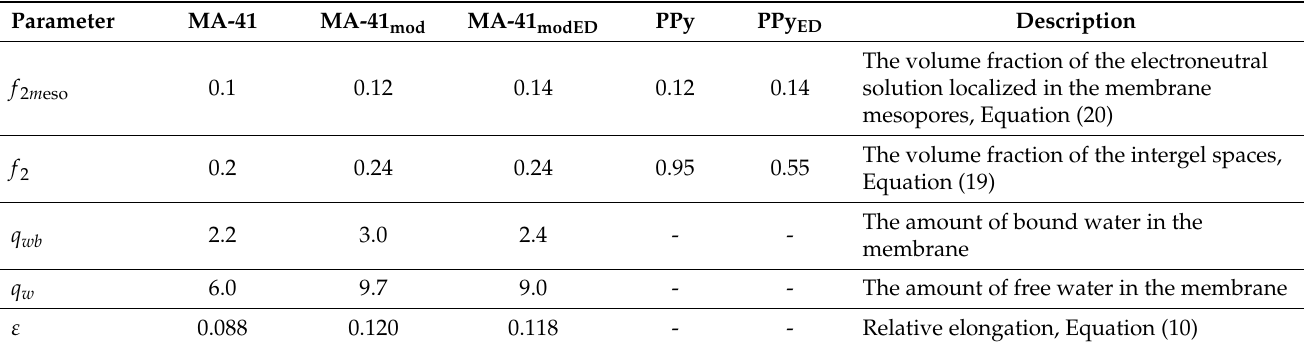
Table 2. The values of some output parameters of the model at c = 1 M